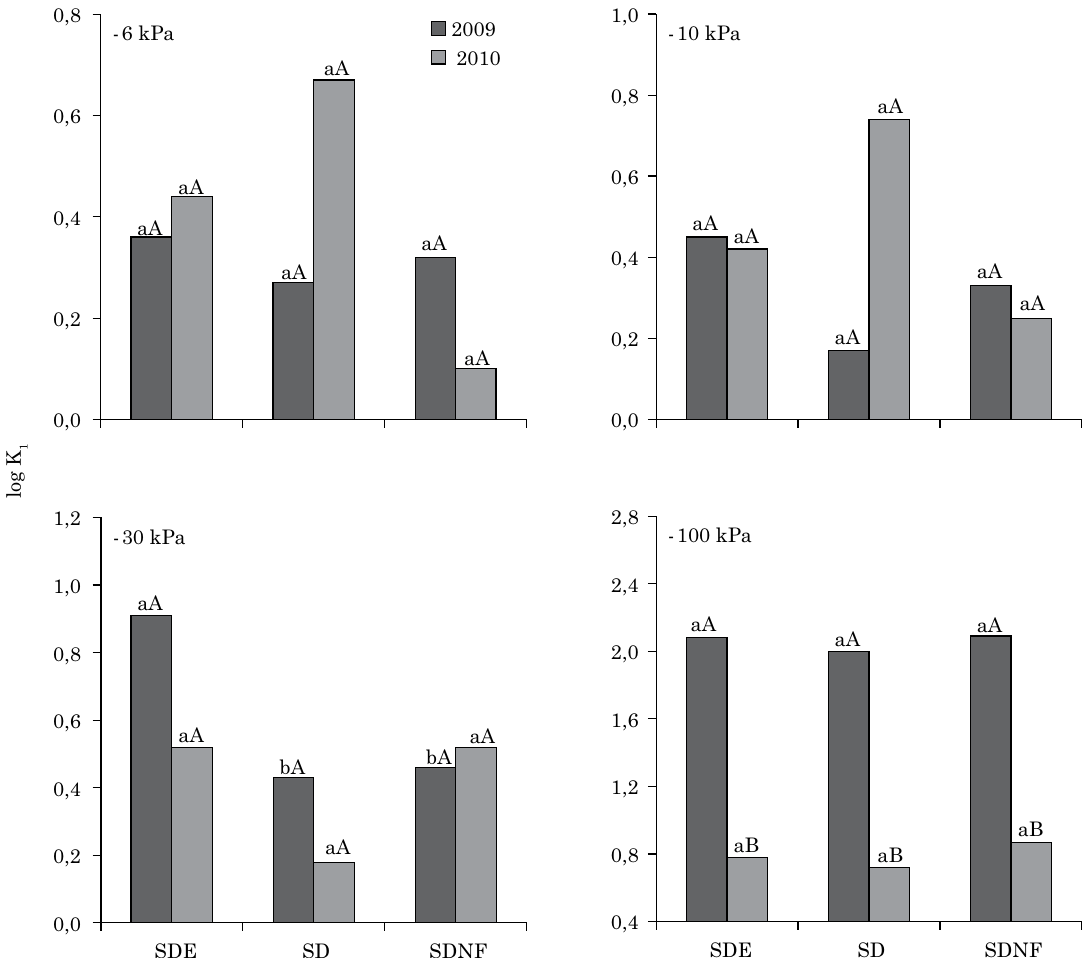
Figura 3. Valores médios de log K 1 (índice de continuidade de poros, K 1 ) para a camada de 0,05-0,10 m com diferentes potenciais mátricos para a cama de semeadura do milho (2009) e da soja (2010) com semeadura direta escarificada (SDE), semeadura direta (SD) e semeadura direta cultivada com nabo forrageiro (SDNF). Barras seguidas de mesma letra minúscula indicam que as médias dos tratamentos não diferem em cada ano e as seguidas de mesma letra maiúscula indicam que as médias entre os anos dentro de cada tratamento não diferiram pelo teste Tukey a 5